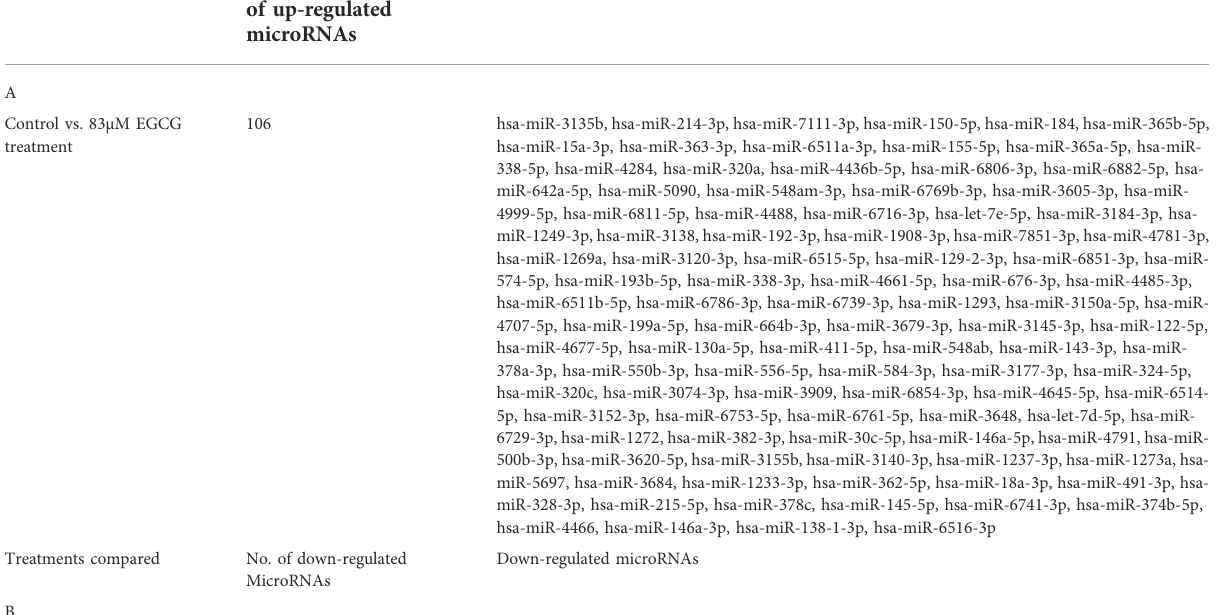
TABLE 2 A: List of all known up-regulated microRNAs after 83 μ M EGCG treatments. B: List of all known down-regulated microRNAs after 83 μ M EGCG treatments. Treatments